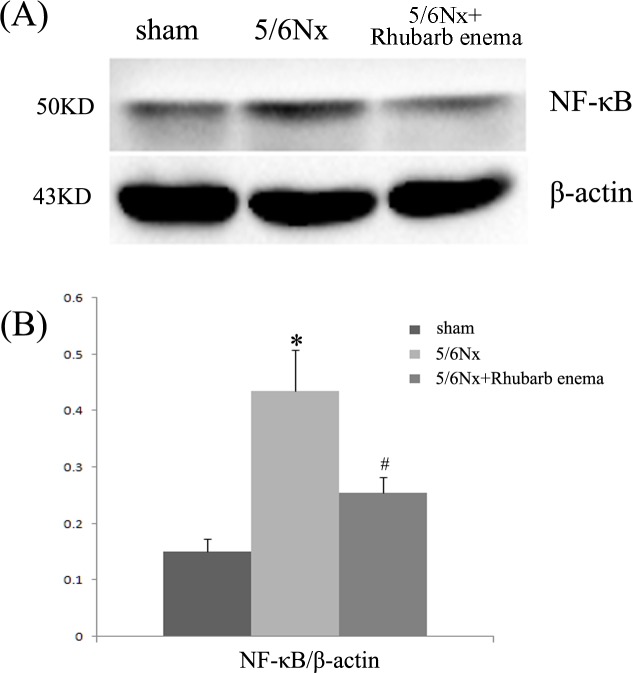
Expression of NF-κB in kidney tissues.(A) Western-blot analysis of NF-κB in kidney tissues. Lane 1 is the sham operation group, lane 2 is the 5/6 nephrectomized group, and lane 3 is the 5/6 nephrectomized with rhubarb enema treatment group. (B) NF-κB protein levels. Data are expressed vs. β-actin and were compared by analysis of variance. *P < 0.05 vs. sham operation group. #
P < 0.05 vs. 5/6 nephrectomized group.